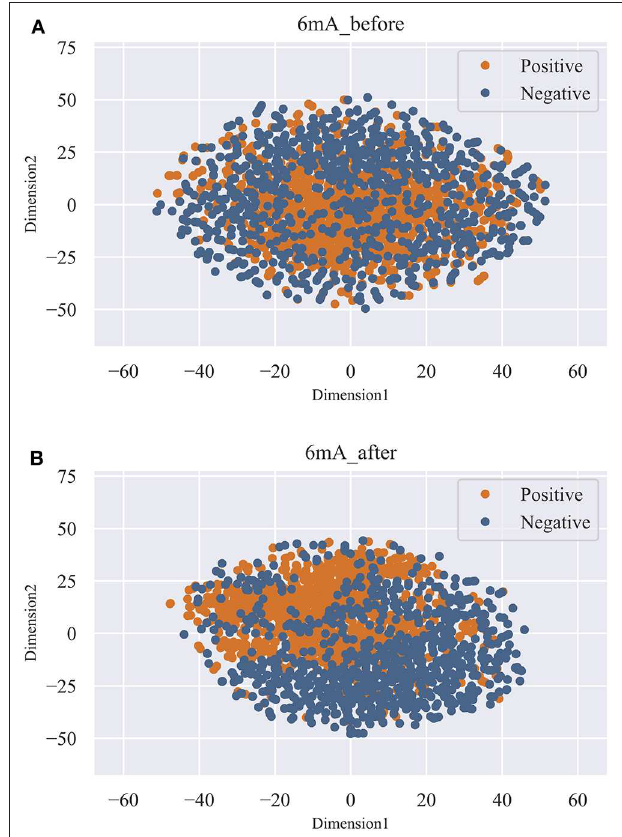
FIGURE 4 | T-SNE visualization of the feature space before and after feature optimization. (A) represents the distribution of the positives and negatives in original feature space. (B) represents the distribution of the positives and negatives in optimal feature space.